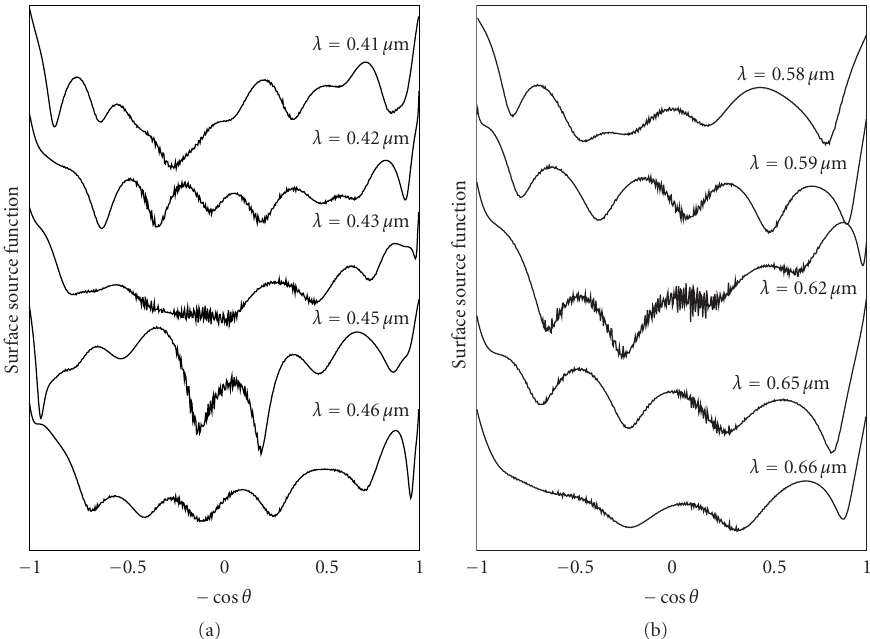
Figure 3: Source functions versus cos(angle) for a single-layer microsphere of 500nm radius, the crystal size of 3.0 nm, and many di ff erent wavelengths. (a) For the wavelengths from 410 nm to 460 nm. (b) For the wavelengths from 580 nm to 660 nm. Other wavelengths between 100 and 1000 nm were treated, but they are not shown here because they do not produce fluctuations. The number of surface peripheral elements was 525. The refractive index on the unit cell edge was chosen to be 2.80 + i0.01. The abscissa tic − 1 corresponds to a point on the particle surface opposite the incident light (in the forward scattering direction) and +1 corresponds to the point nearest the incident light source (in the back scattering